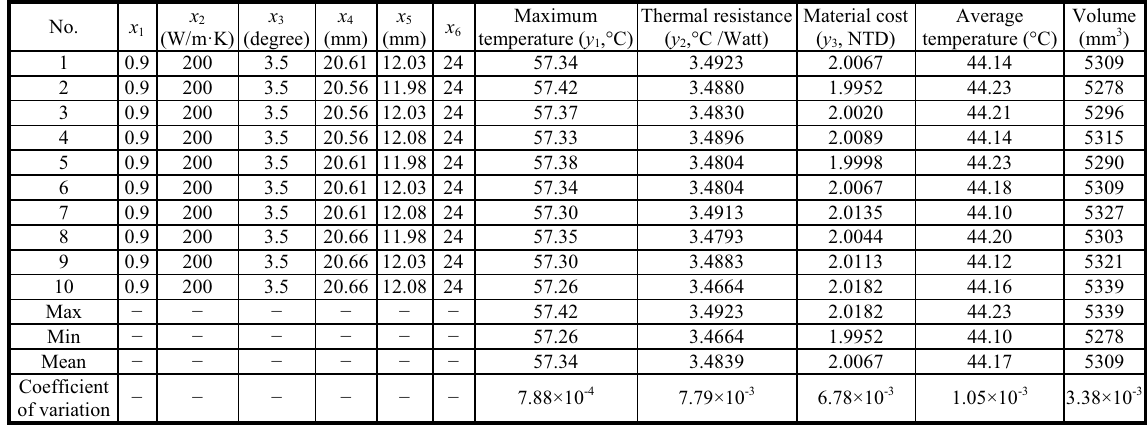
Table 11. Summary of confirmation experiment